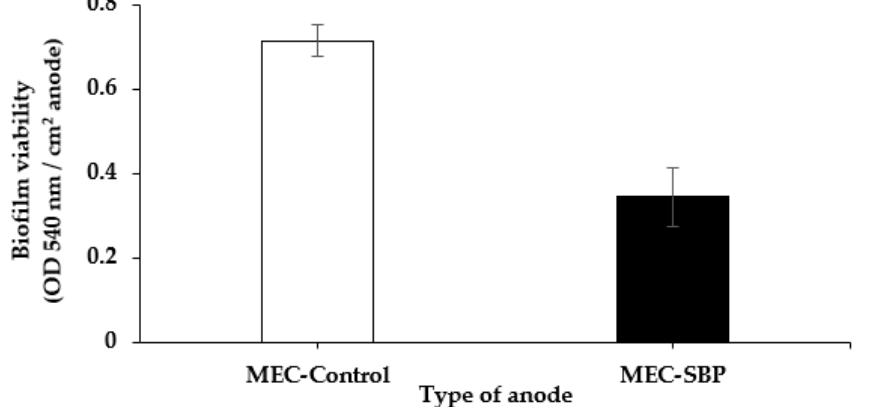
Figure 7. MTT analysis of the biofilm viability on the different anodes, MEC-SBP ( ◼ ) and MEC control ( □ ) at the end of MEC operation. The results are normalized per one cm 2 anode. p -value ( t control ( (cid:3) ) at the end of MEC operation. The results are normalized per onecm 2 anode. p -value test): p < 0.05. ( t test): p <